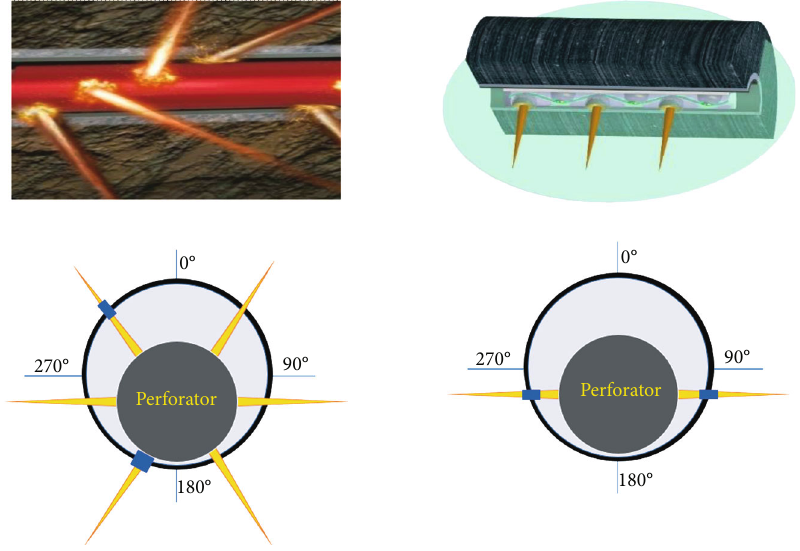
Figure 11: Comparison diagram of before and after perforation